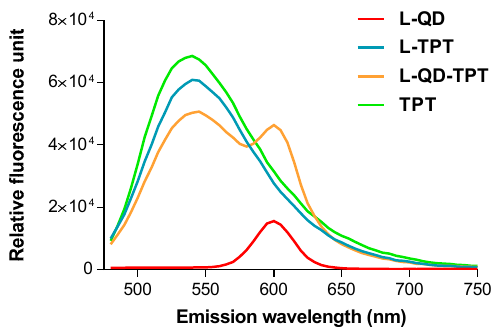
Figure 1. The fluorescence spectra of liposome-quantum dot (L–QD) (red), liposome-topotecan (L-TPT) (turquoise), L–QD–TPT (orange) and free TPT (green). The excitation wavelength was set at 450 nm.